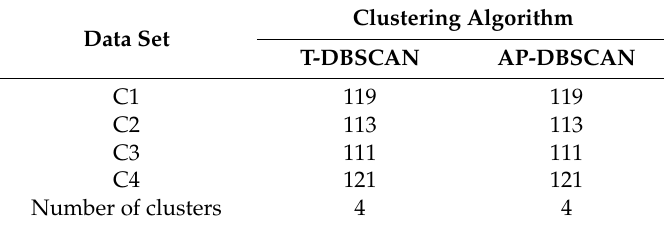
Table 2. Comparison of calculated data by two methods for railing sensors.